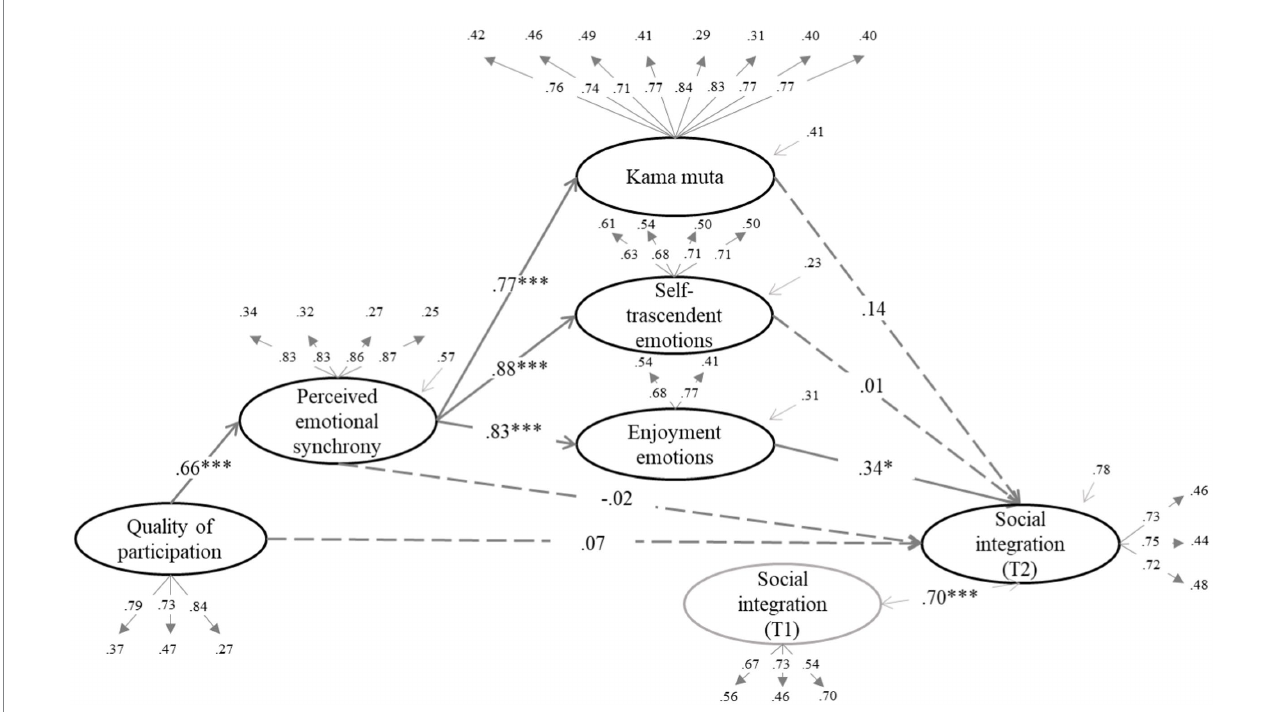
FIGURE 1 Perceived emotional synchrony and emotions as mediators of the effect of quality of participation on social integration controlling for pre-participation scores. Model fit: χ 2 = (404, 313) = 811.975, p < 0.001, CFI = 0.920, TLI = 0.910, RMSEA = 0.063, SRMR = 0.058.